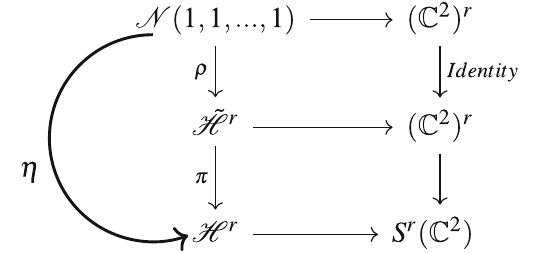
Fig. 8 Commutative diagram that determines the morphism ρ : N ( 1 , 1 ,..., 1 ) → ˜ H r from nested Hilbert scheme to the isospectral Hilbert scheme, such that η = π.ρ